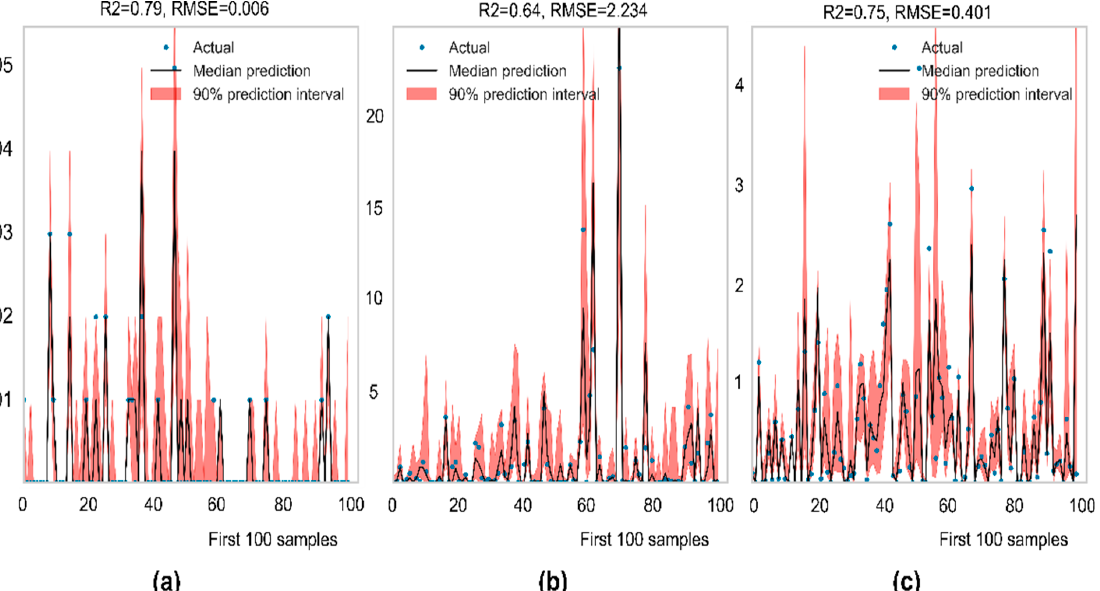
Table 6. Coverage probability of 90% prediction intervals from different inputs: PICP (MPI).